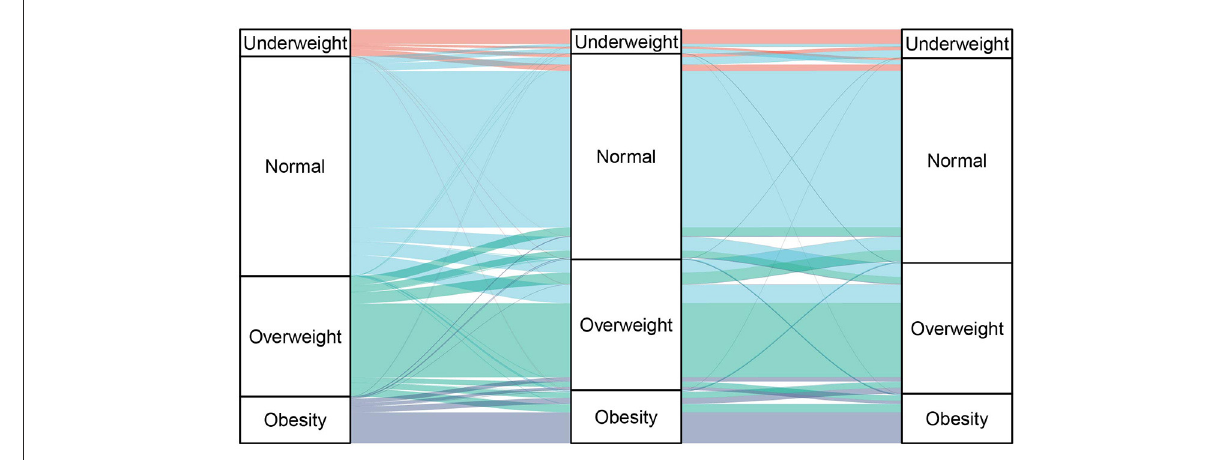
FIGURE1 Longitudinal transition on BMI status among Chinese middle aged and older adults across three